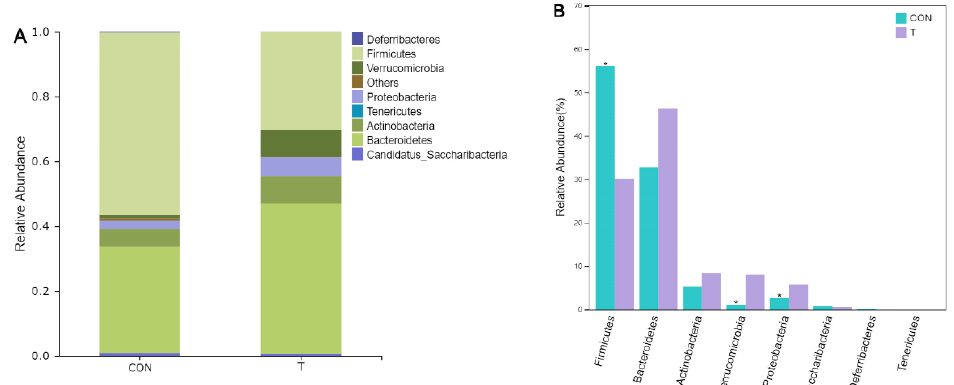
Figure 9 . ( A ) Comparison of intestinal bacteria species distribution in mice at phylum level; ( B ) Comparison of intestinal bacteria species classification in mice at phylum level. * indicates significant difference between groups ( p < 0.05), and no * indicates no significant difference ( p > 0.05).